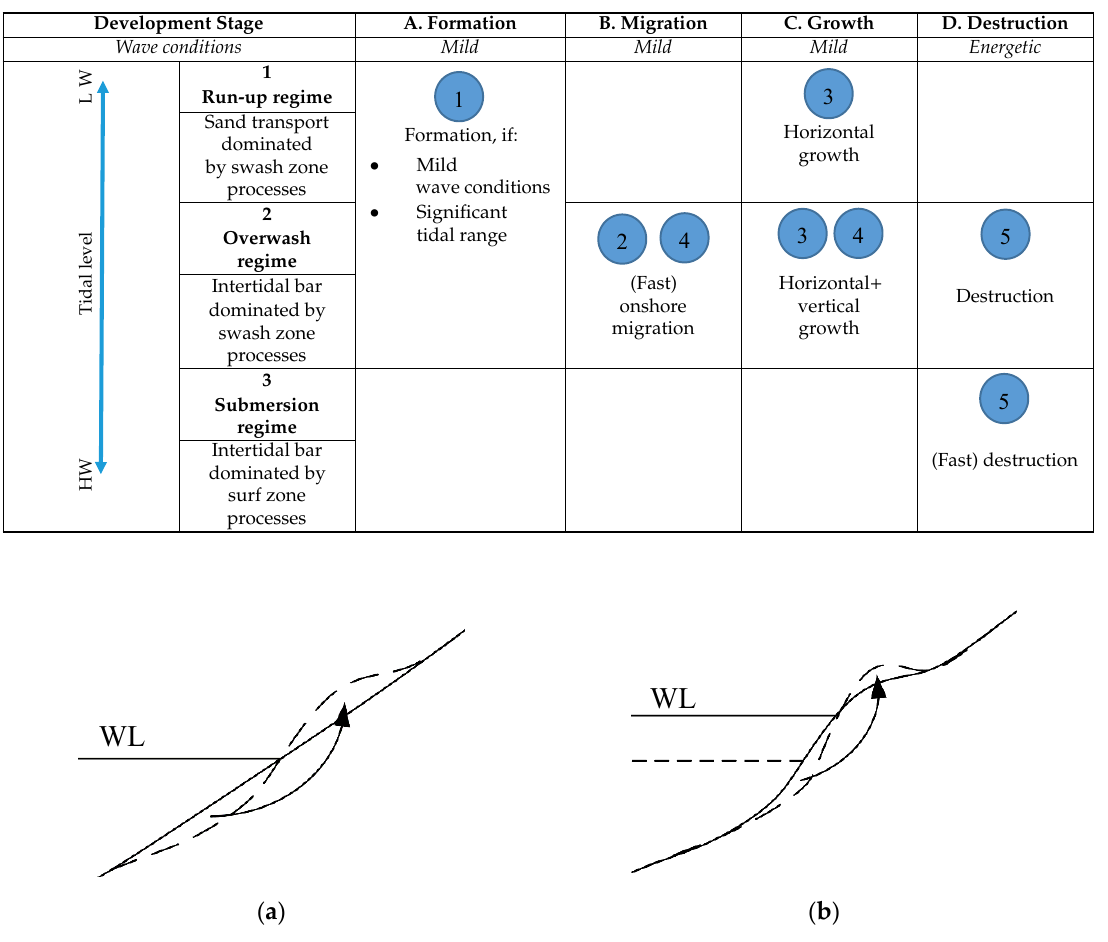
Table 1. Conceptual model on the formation, migration, growth, and destruction of an intertidal bar, based on the prevailing regime, i.e., run-up, overwash, or submersion. The numbers 1–5 indicate the bar movements as seen in Figure 7.